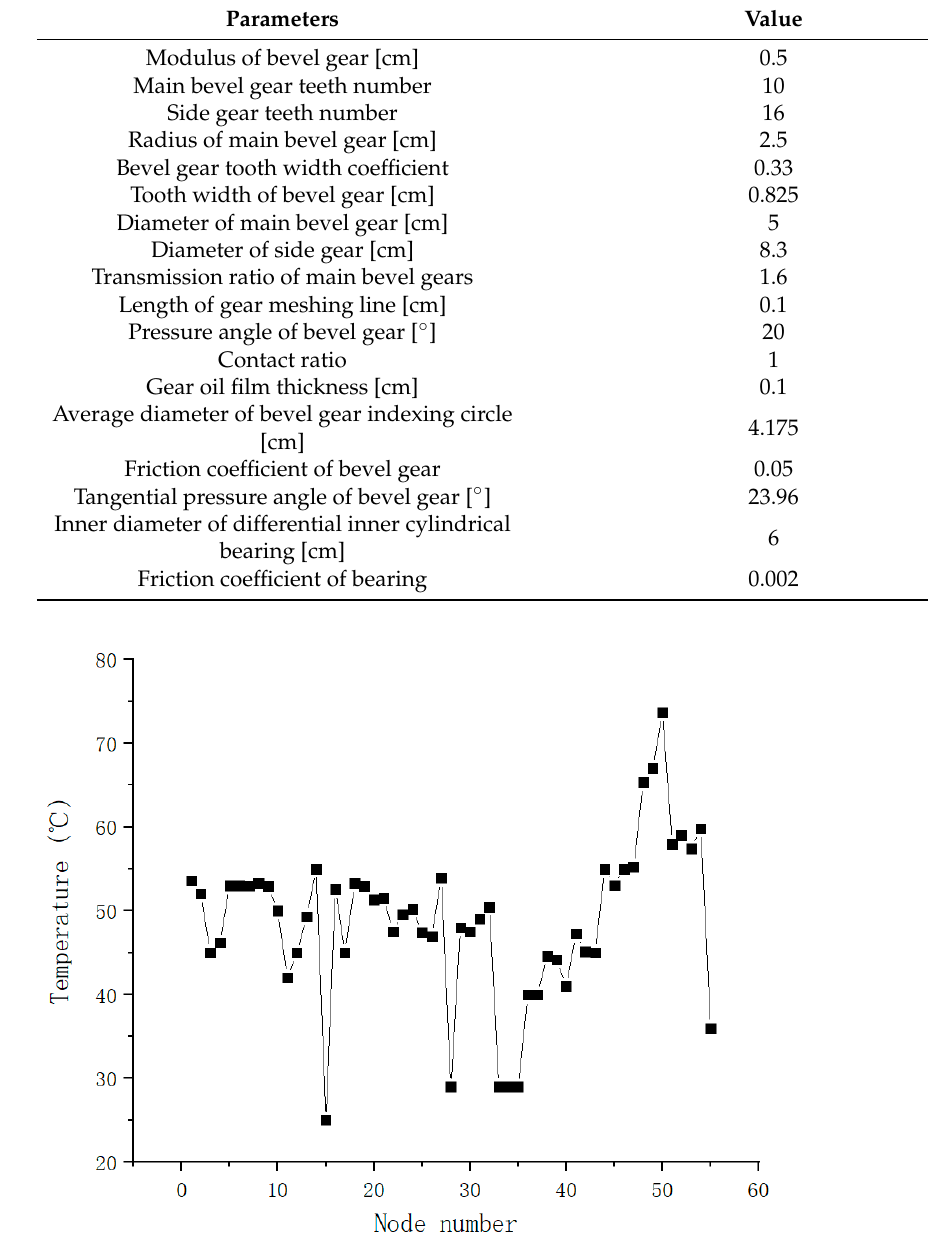
Figure 3. The TFD of the two-axle automobile drive axle ( p = 22 kW).